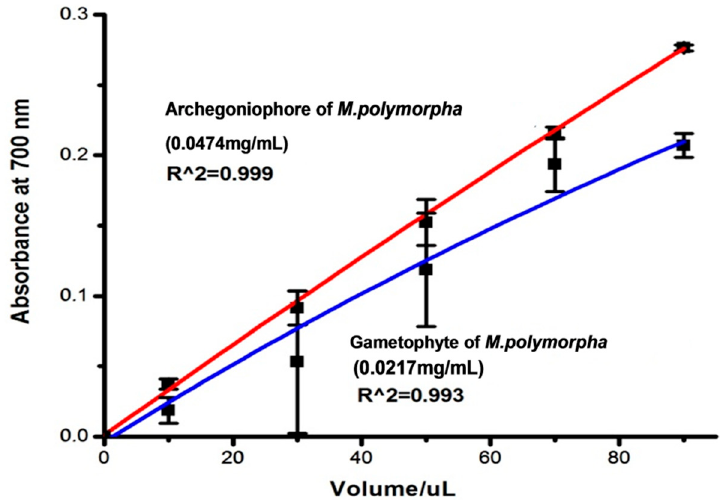
Figure 5. The reducing power of archegoniophore and gametophyte of M. polymorpha L . ( n = 3).